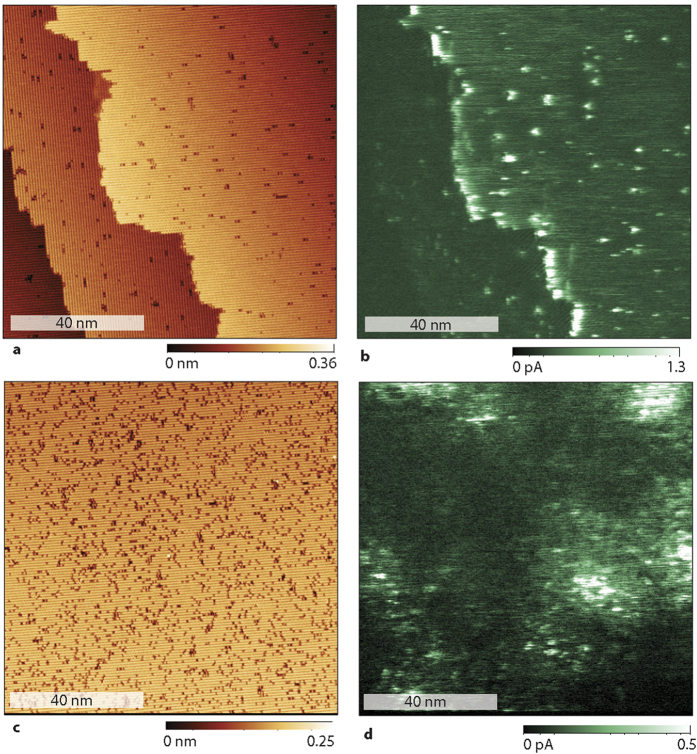
STM images and conduction AFM images of a surface of a P-doped c-Si crystal right after a flash anneal (a,b) and after one day (c,d).Initially, the surface has very few defects apart from step edges (a). After a day, the surface has more defects present (c). (b) A dark conduction AFM image taken at the same location and shortly after image (a) at a tip-bias voltage of 1.2 V. It shows that current maxima occur only at a few point-like defects which exist at the surface an at step edges. (c) After a day, a higher defect density has developed and now the P-donor patches appear in the dark conduction AFM image (d).